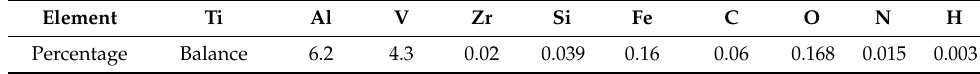
Table 1. Chemical composition of the Ti-6Al-4V alloy in wt.%.